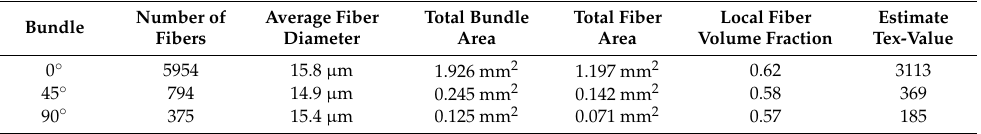
Table 1. Quantification from the fiber segmentation inside the